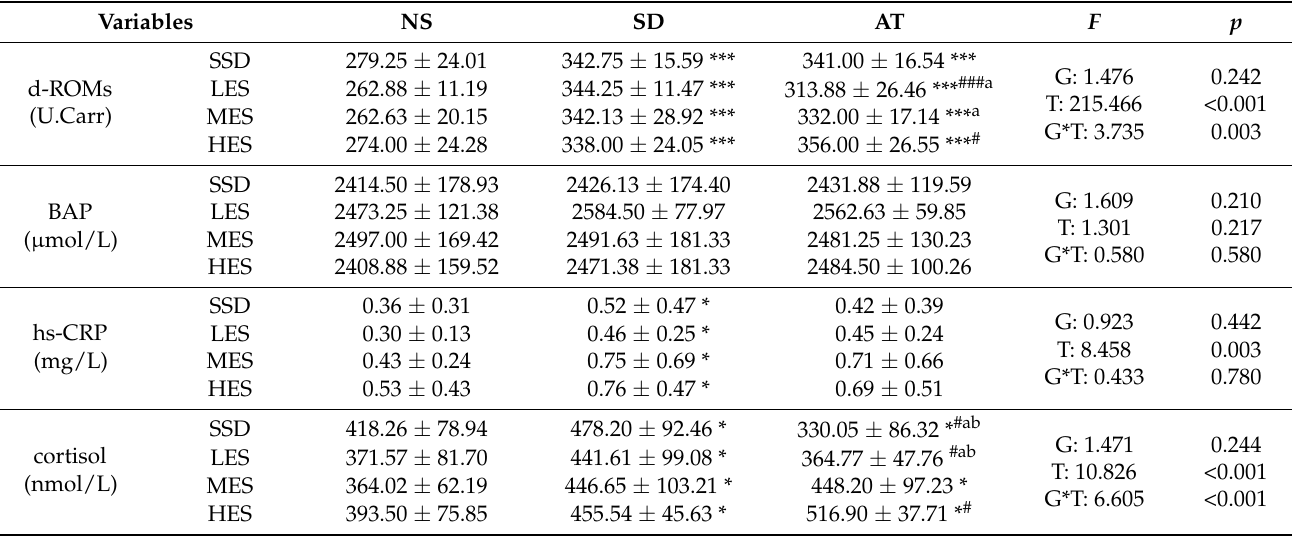
Table 4. The differences in oxidative stress, hs-CRP and cortisol between groups and times.